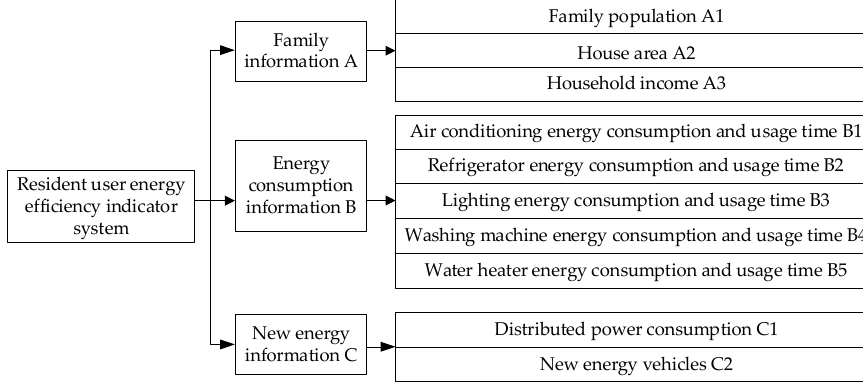
ffi ciency indicator